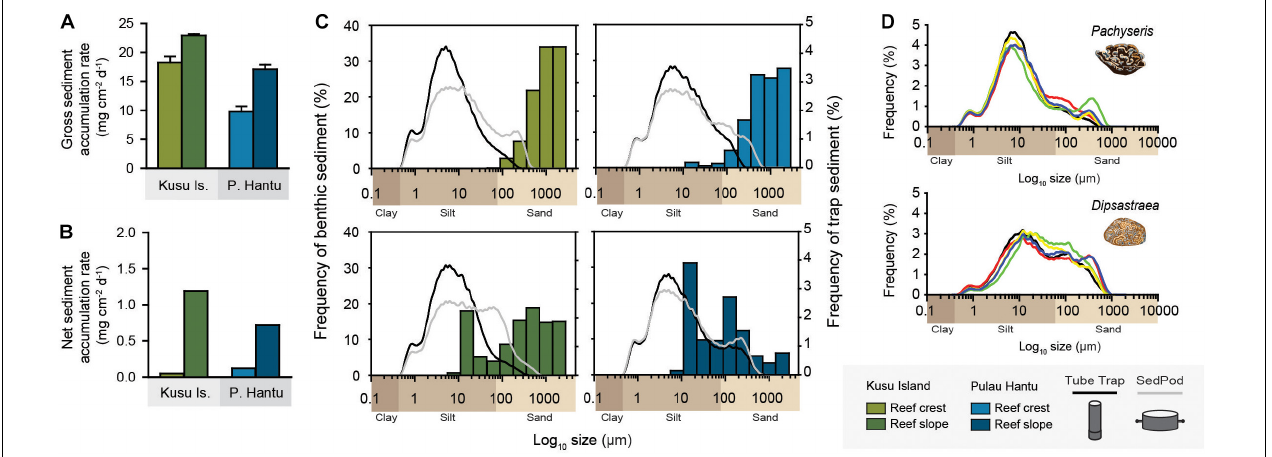
FIGURE 6 | (A,B) Gross and net sediment accumulation rates (mg cm − 2 day − 1 ) derived from traps deployed within reef crest (2–3 m depth) and reef slope habitats (7 m depth) at Kusu Island (green) and Pulau Hantu (blue) reefs over a 30-day period (August 2018). (C) Log of particle size distribution (%) of sediments ( µ m) collected in tube traps (black line), SedPods (gray line) and benthic sediments (bars). (D) Log of particle size distribution (%) of coral surface sediment of foliose Pachyseris sp. and massive Dipsastraea sp.